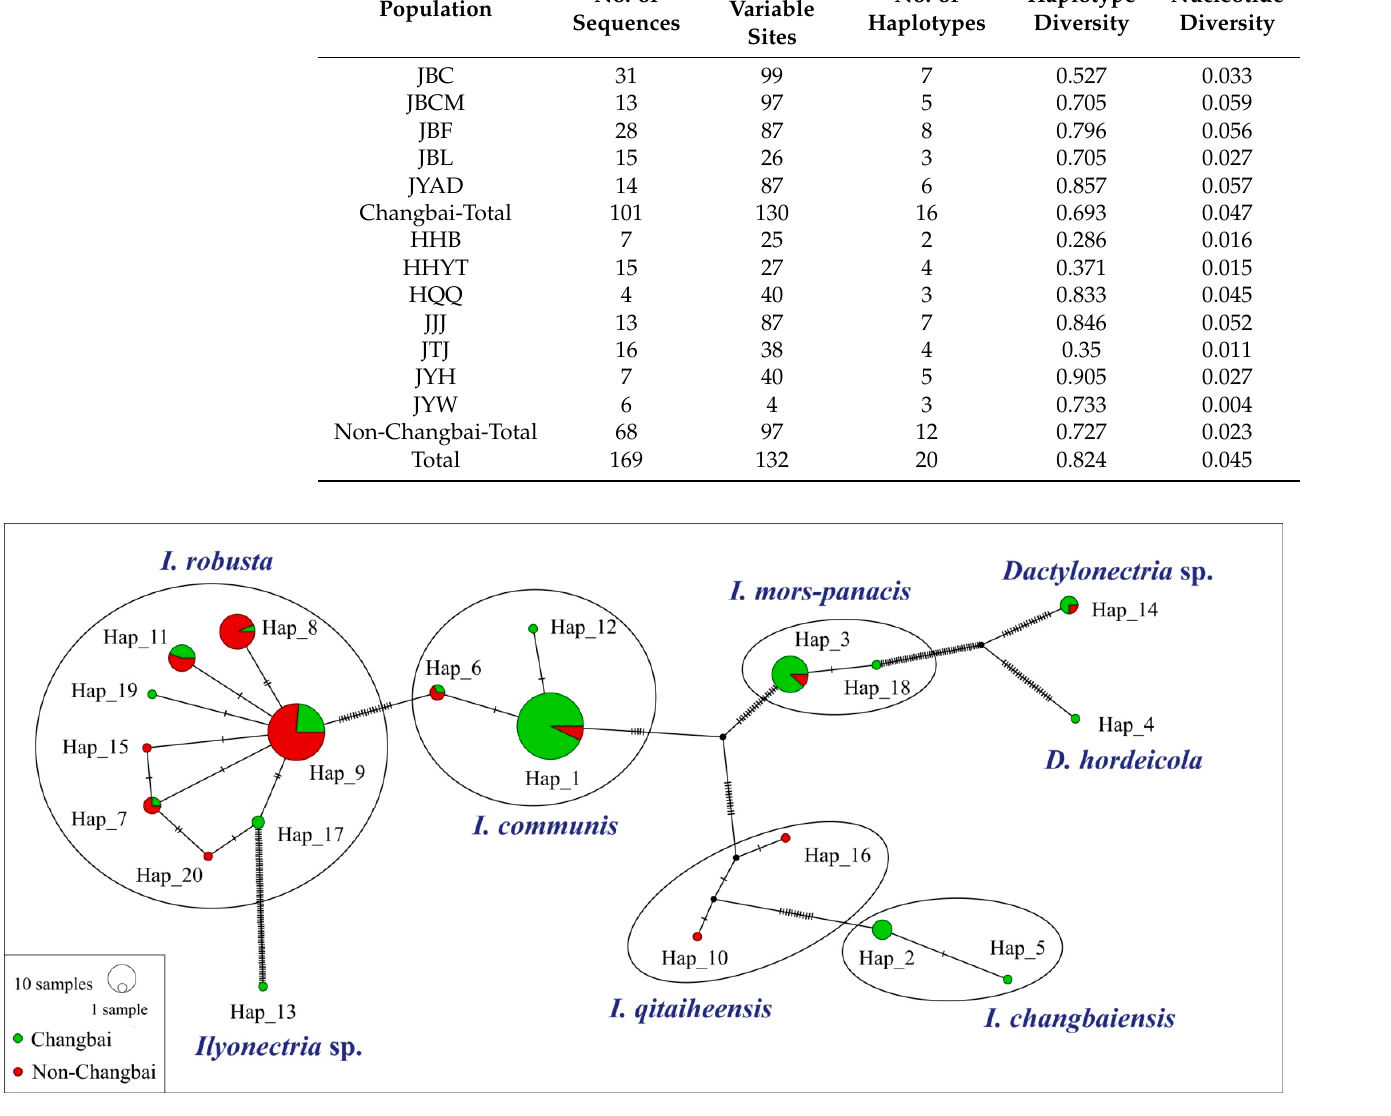
Figure 3. TCS haplotype network generated for his3 gene sequences representing two geographical groups of Cylindrocarpon -like fungi. The size of the circle indicates the frequency of haplotype in the population. Hatch marks indicate the number of mutations. The F ST values between populations ranged from − 0.0967 to 0.731, and more than half of F ST values showed significant differentiation (Table 5). The highest F ST value (0.731) with significant differentiation was observed between the JTJ and JBL populations, and the lowest F ST value ( − 0.097) without significant differentiation was between JYH and HHB. Table 5. Pairwise F ST values among 12 populations of Cylindrocarpon -like isolates.